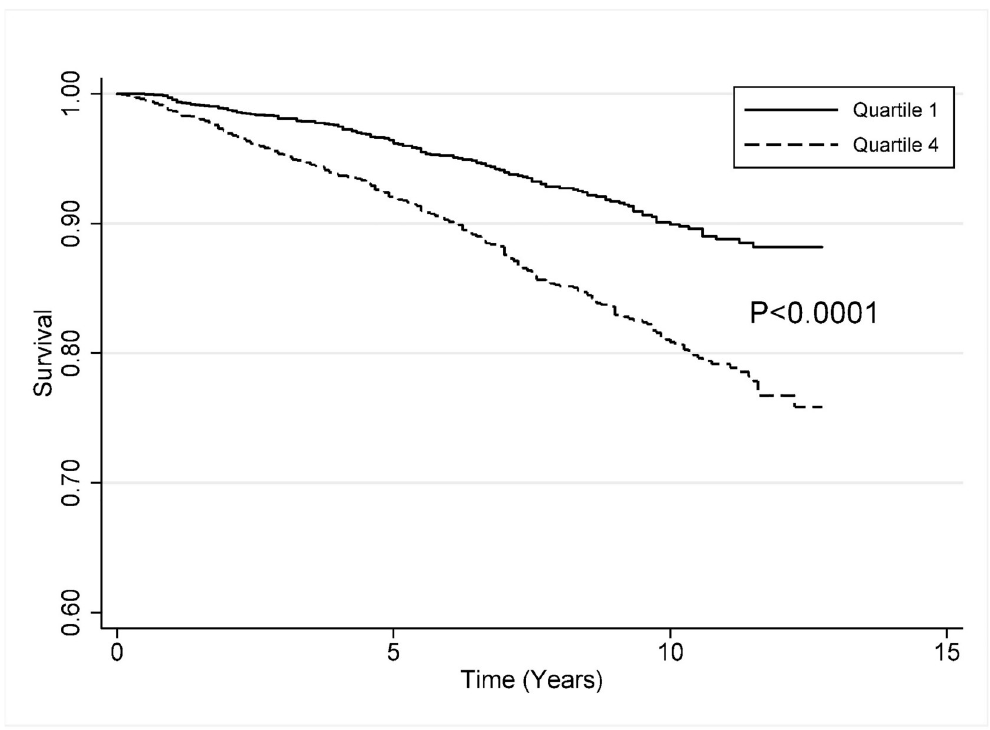
Fig 2. Kaplan-Meier curve comparing survival rates of the lowest and highest quartiles of normalized urinary genistein. There was a statistically significant higher survival rate among individuals in the first quartile of normalized urinary genistein (nUG) compared to those in the fourth quartile of nUG (p < 00001).